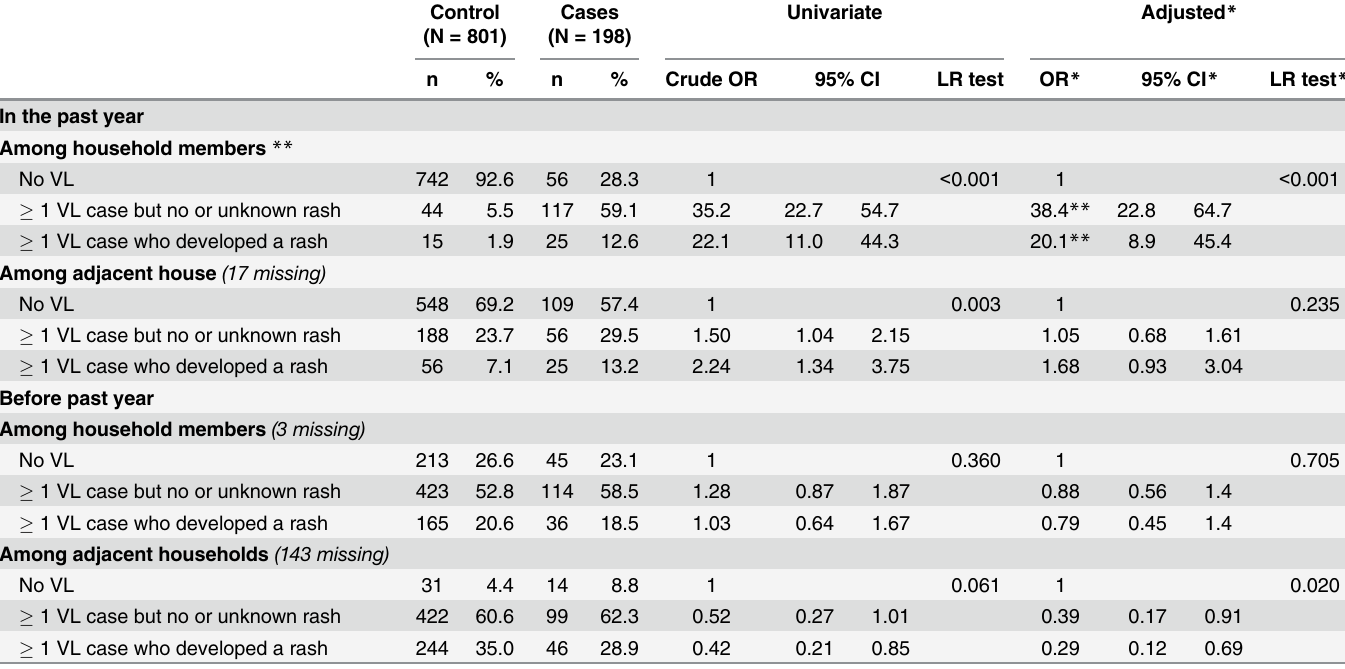
Table 4. Patients with visceral leishmaniasis in the household or an adjacent house: crude and adjusted analysis. Gedaref State, Sudan, 2012 – 2013.